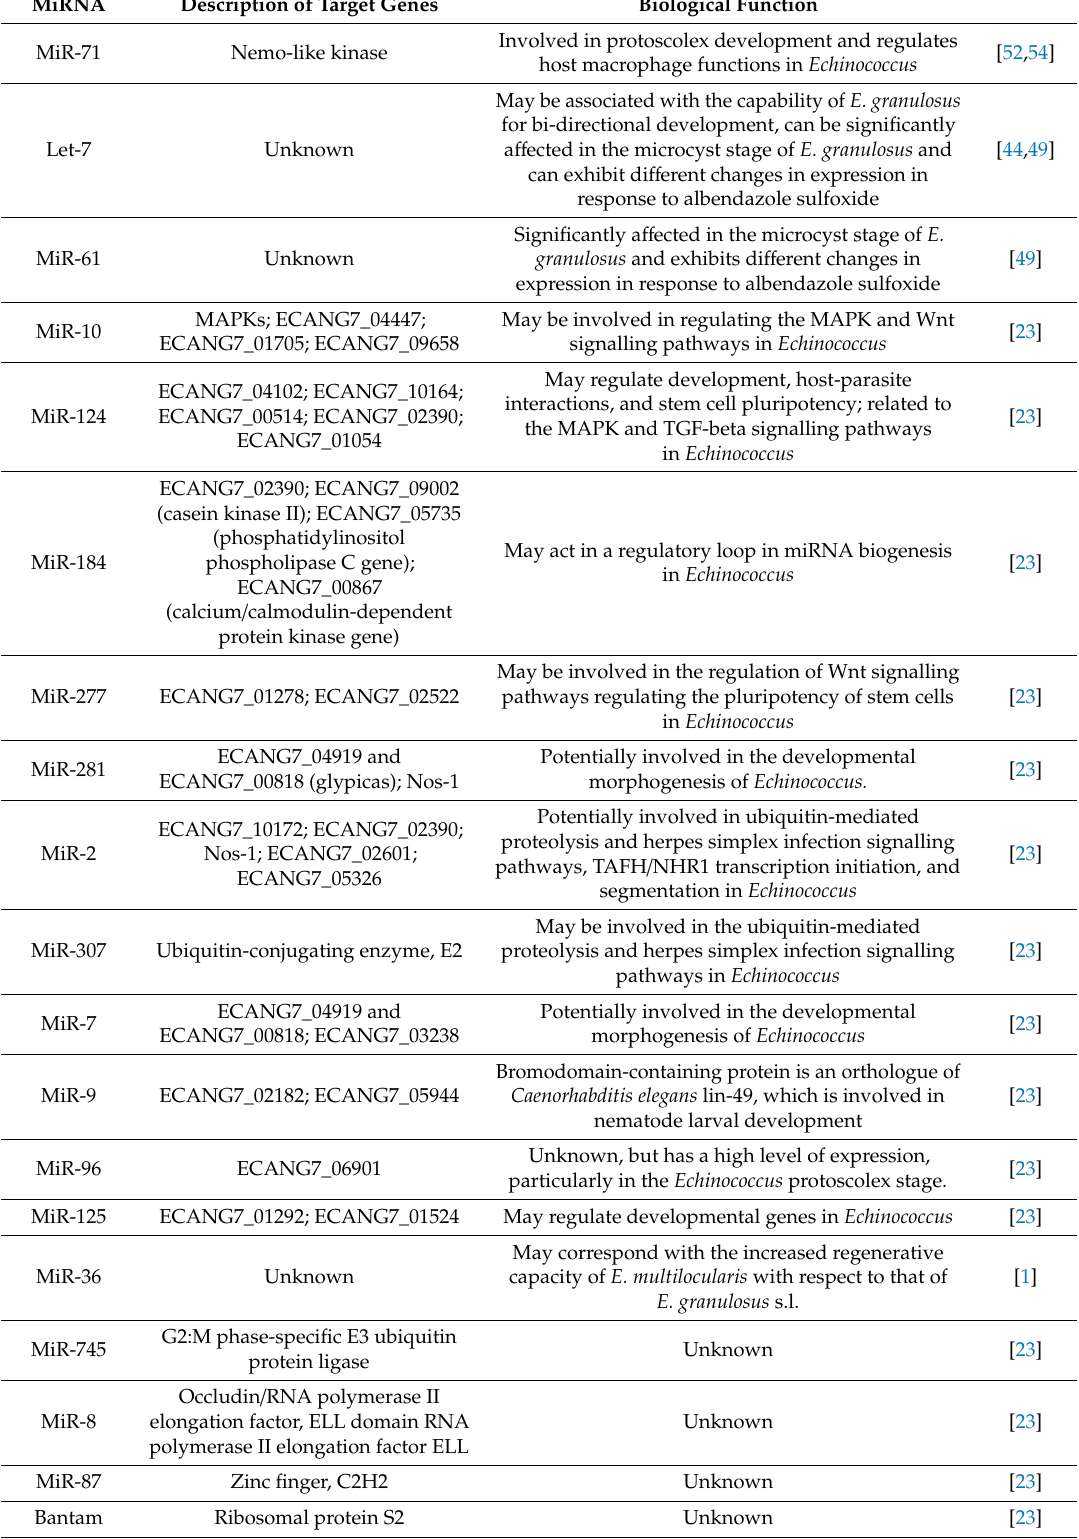
Table 2. Common miRNAs in Echinococcus